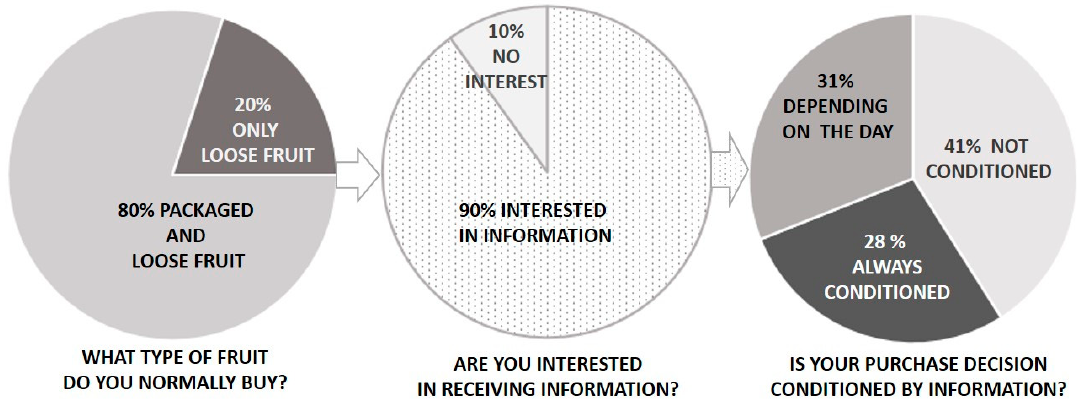
Figure 1. Consumer purchase practices and interests in information. Consumers response to different questions about purchase habits and information